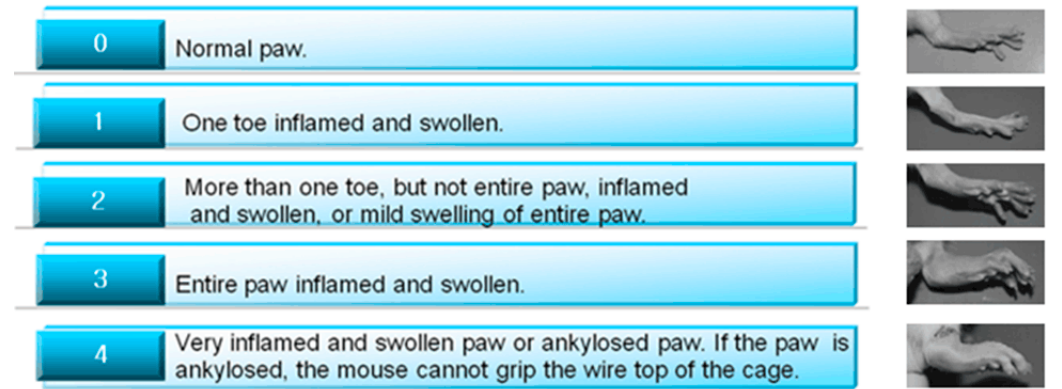
Figure 9. Paw score of the CIA in the clinical observations.